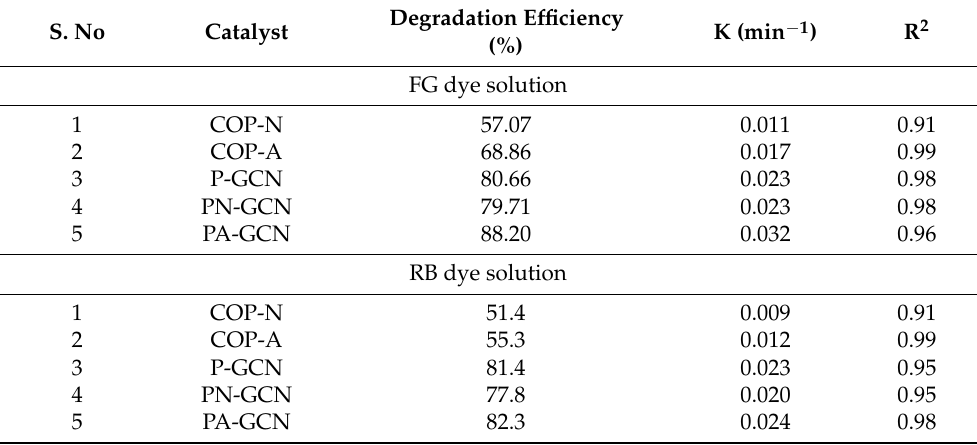
Table 1. Degradation parameters of COP-N, COP-A, P-GCN, PN-GCN, and PA-GCN against FG and RB dye solution. S. No Catalyst